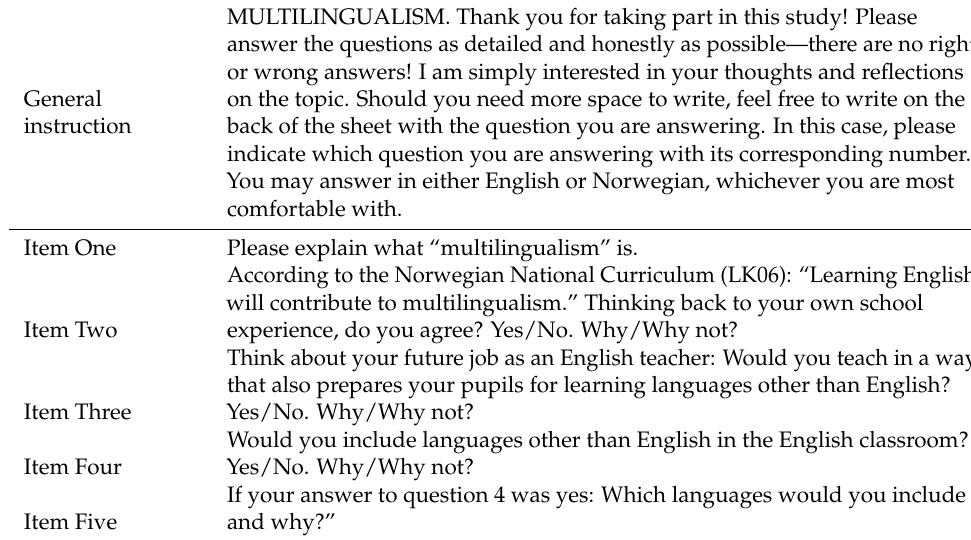
Table 4. General instruction and items included in section 1 of the